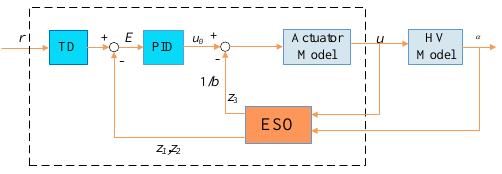
Figure 3. The construction of ADRC. r is the desired angle of